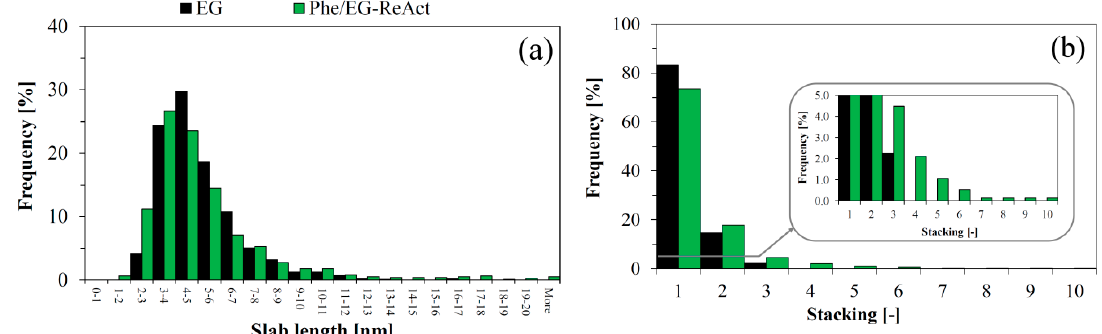
Figure 6. Particle size distribution for spent catalysts from experiments EG and Phe/EG-ReAct: ( a ) Slab length; ( b ) stacking. Based on >700 slabs in >40 TEM images for each sample.